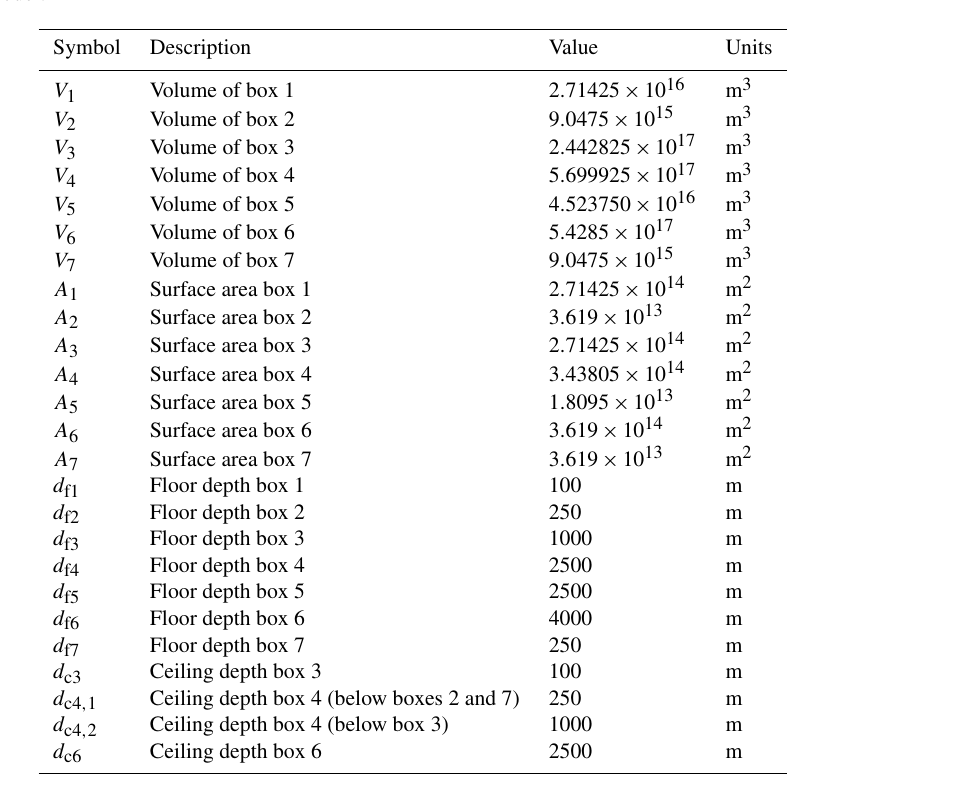
Table A2. Symbol (column 1), description (column 2), value (column 3), and units (column 4) of parameters concerning the dimensions of the boxes used in our